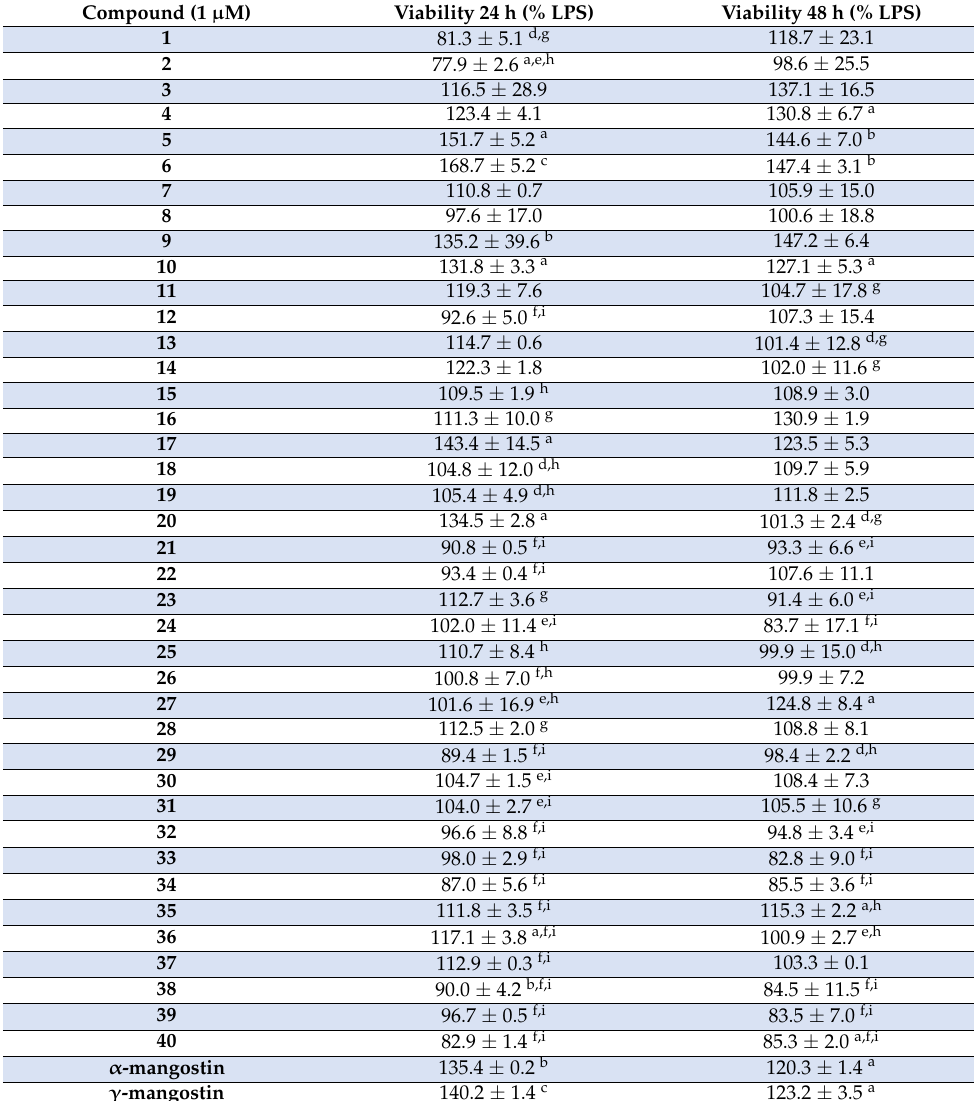
Table 2. Cell metabolic activity percentages in the presence of compounds 1 – 40 at 1 µ M obtained from the MTT